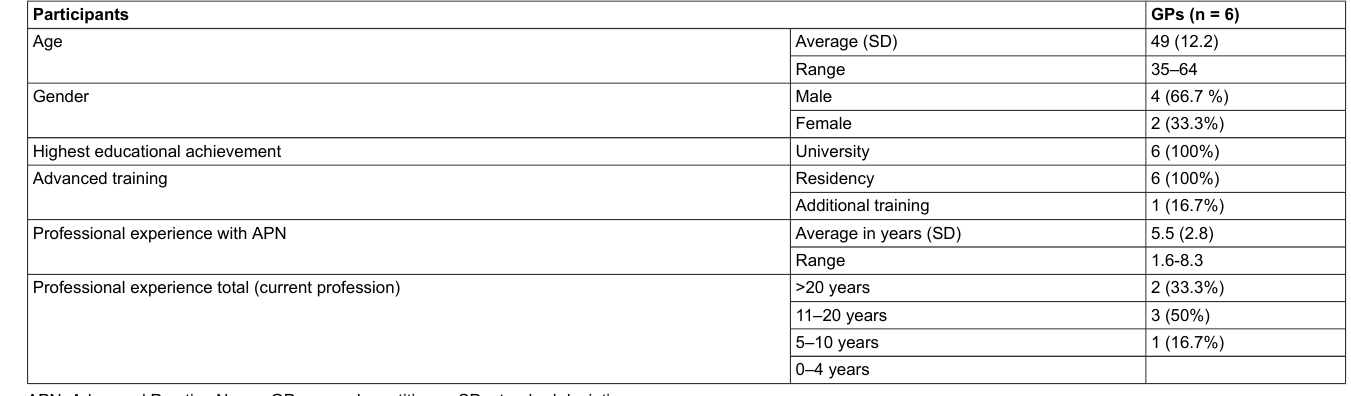
Table 2: Characteristics of individual